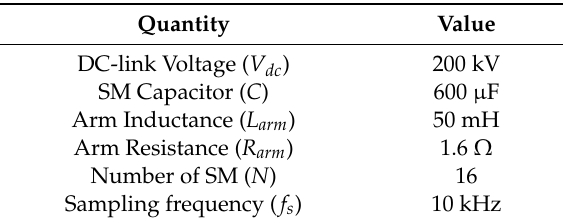
Table 2. MMC Parameters.